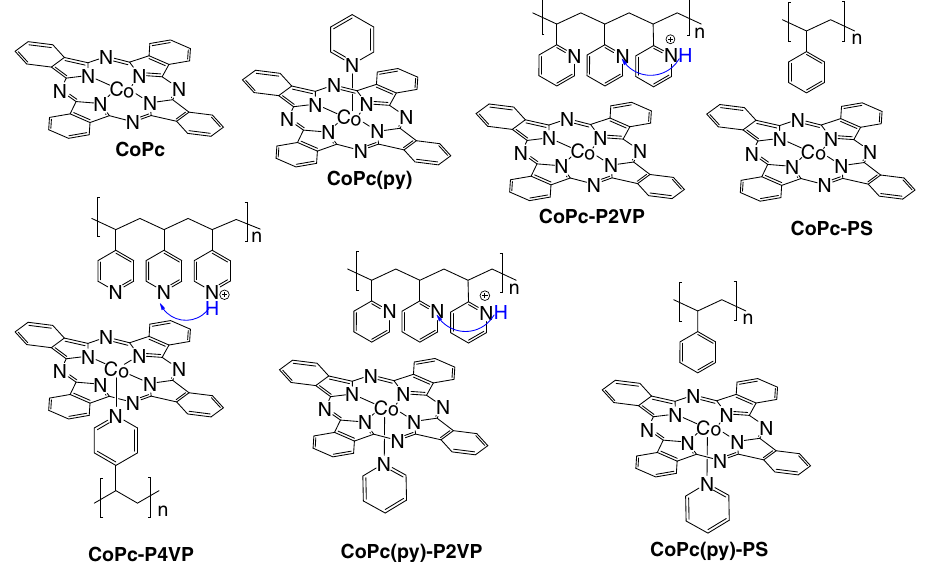
Fig. 2 Catalyst and polymer-catalyst composite systems investigated in this work along with their postulated coordination environment and proton relays